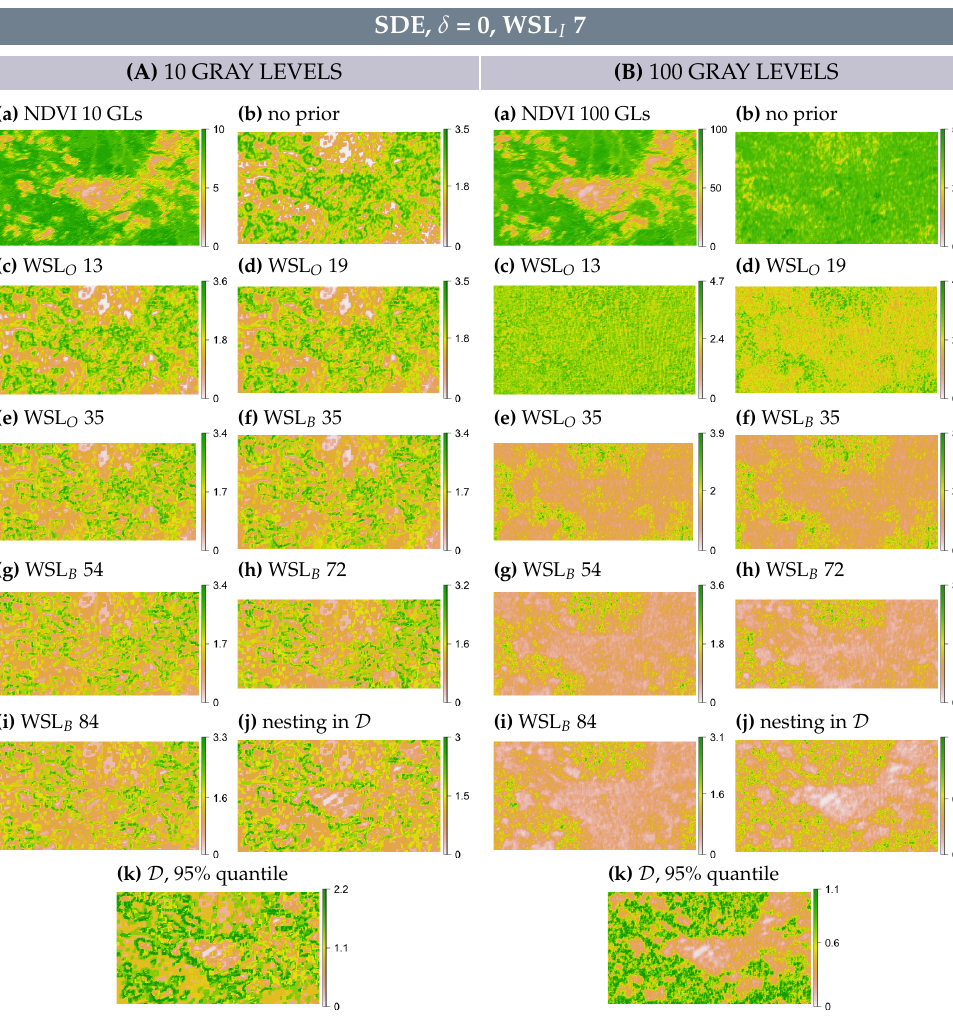
Figure 5. Structural diversity entropy (SDE), δ = 0, WSL I 7. Minimum values displayed are set to 0. (A,B) (k) Nesting in D , 95%